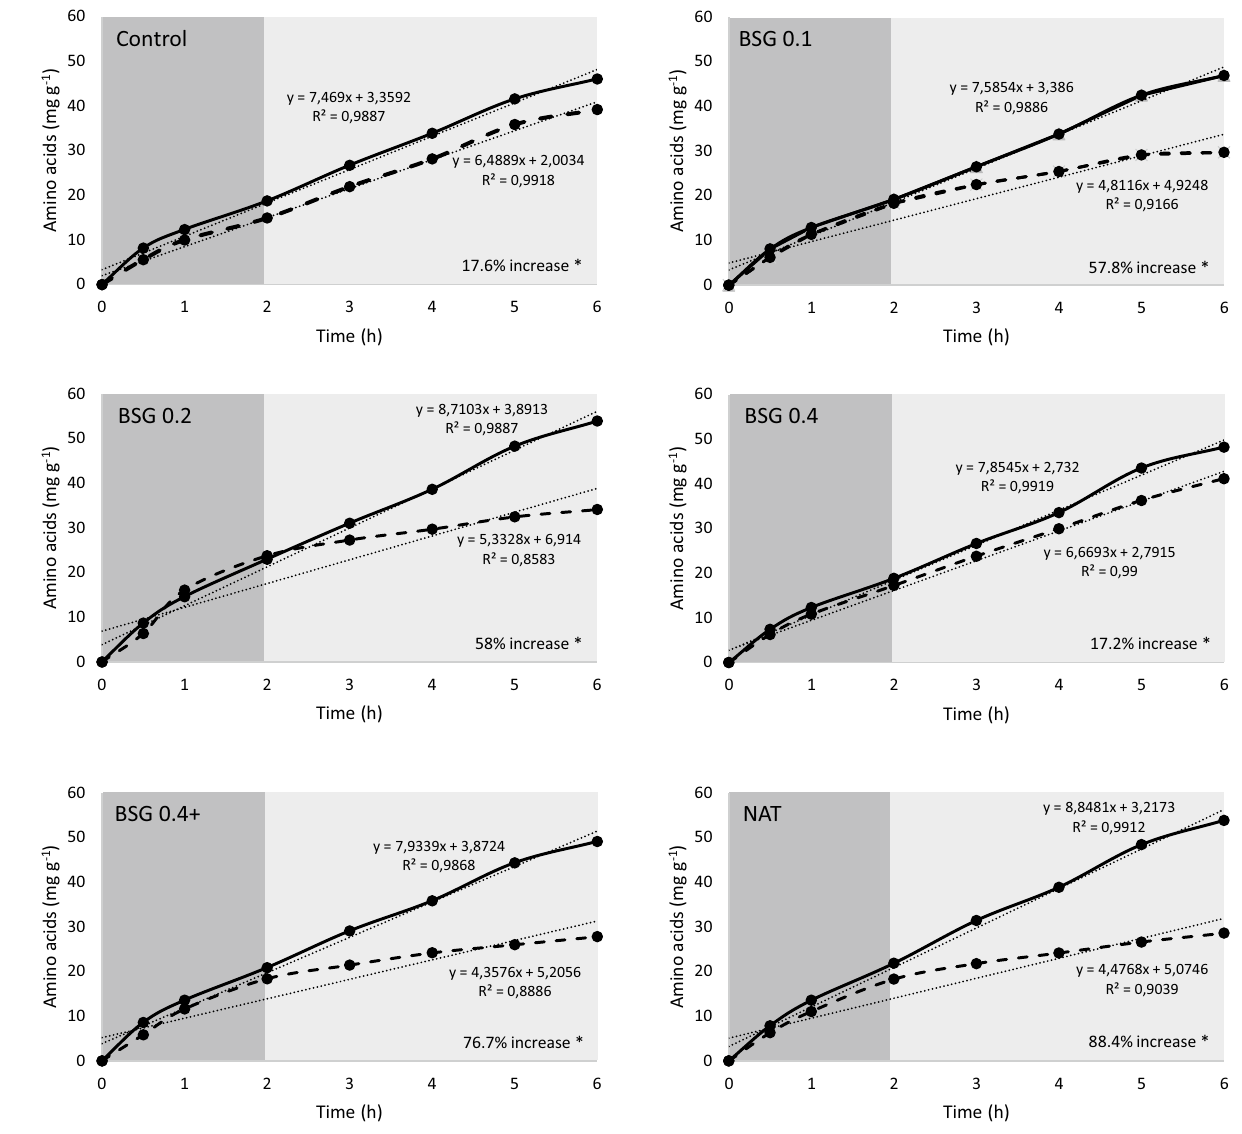
Figure 5. Amino acids release (mg g −1 of diet) from the different experimental diets under the simulated conditions of the European seabass digestive tract with active (continuous line) and inactive fish enzymes (dashed line). The slope of linear fitting provides the rate of release of amino acids per hour (mg g −1 of diet h −1 ). Stomach and intestinal digestions are represented in dark and light grey, respectively. Values expressed as mean ± standard deviation. Asterisks indicate significant differences between active and inactive fish enzymes (p <